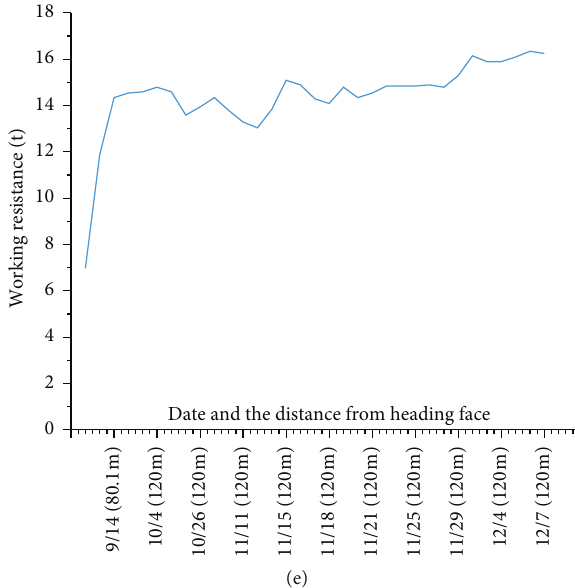
Figure 19: Curves of working resistance of bolts and cable anchors with increasing driving distance. (a) No. 1 bolt dynamometer at station #1, (b) No. 1 bolt dynamometer at station #2, (c) No. 1 bolt dynamometer at station #3, (d) No. 1 cable anchor dynamometer at station #2, and (e) No. 1 cable anchor dynamometer at station #3.